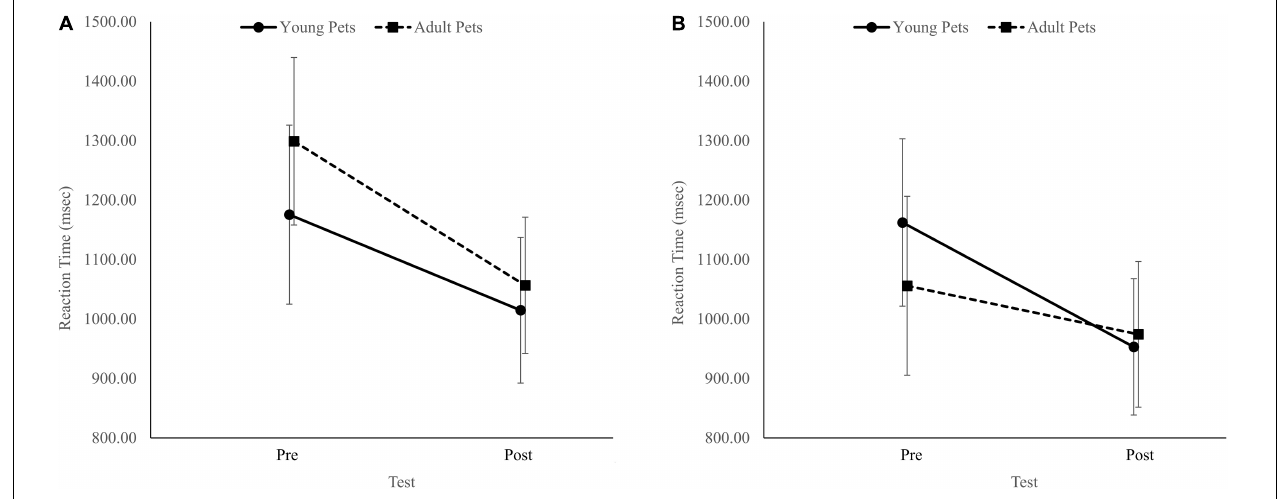
FIGURE 2 | The interaction between groups (adult pets’ images/young pets’ images) and test timing (pre/post) for non-pet owners (A) and pet owners (B) for the alternate task-switching task reaction time. Error bars represent 95% confidence intervals.